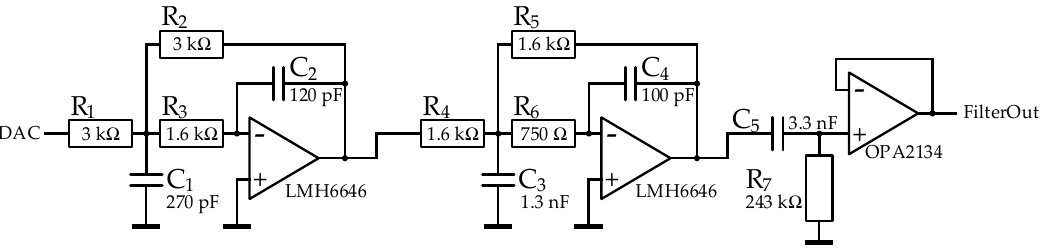
Figure 3. Circuit diagram of the analog low pass and high pass filter.